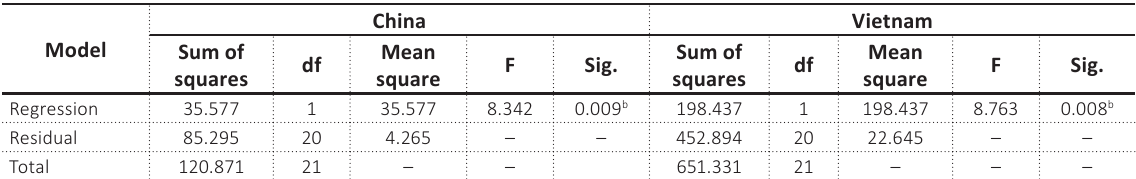
Table 8. China’s and Vietnam’s ANOVA a of lending interest and inflation